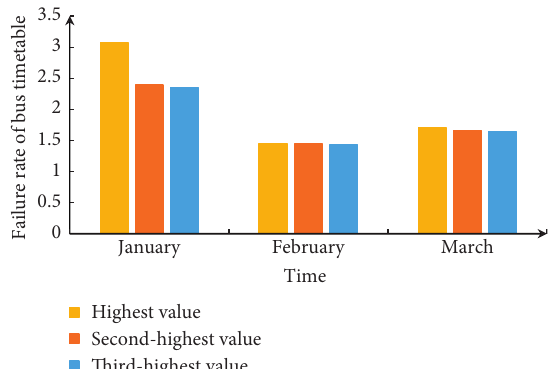
Figure 5: Peak diagram of timetable failure rate.